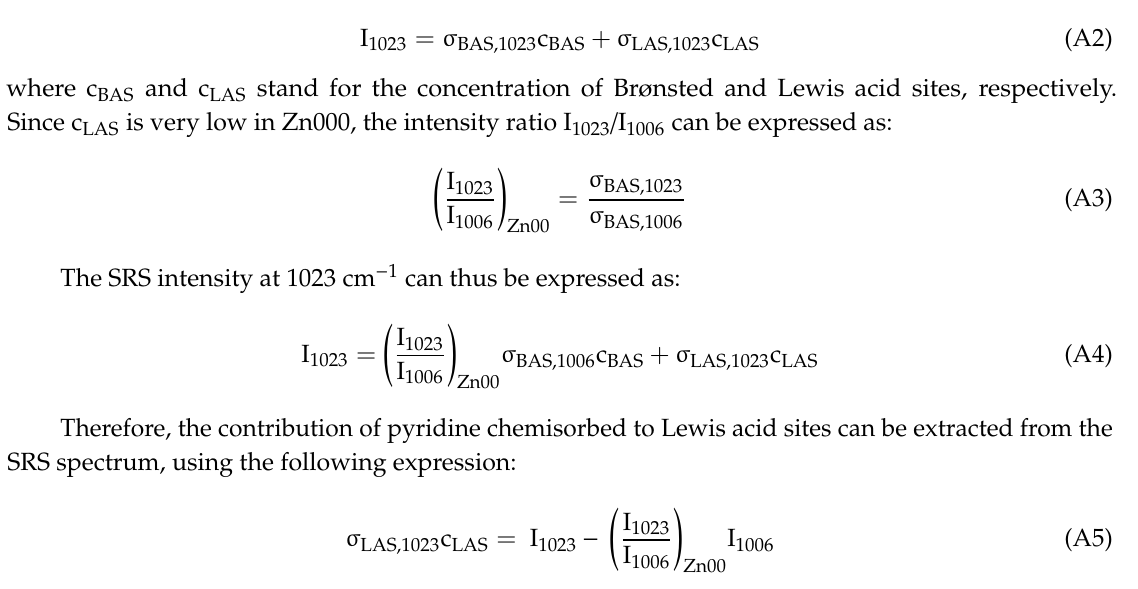
Figure S1: Nitrogen adsorption and desorption isotherms of the protonated and zinc-exchanged ZSM-5 zeolites, Figure S2: XRD patterns of the protonated and zinc-exchanged ZSM-5 zeolites, Figure S3: UV-visible di ff use reflectance spectra of the protonated and zinc-exchanged ZSM-5 zeolites as well as nanoparticles of ZnO, Figure S4: Spontaneous Raman spectra of pyridine in di ff erent environments, Figure S5: SRS images and spectra of chemisorbed pyridine in Zn000 crystals after desorption, Figure S6: Typical EDX spectrum of a Zn600 crystal acquired by point-analysis, Table S1: Textural properties of the protonated and zinc-exchanged ZSM-5 zeolites determined from nitrogen physisorption measurements, Table S2: Statistical analysis of the intensity ratio of the SRS signal at 1006 and 1023 cm −